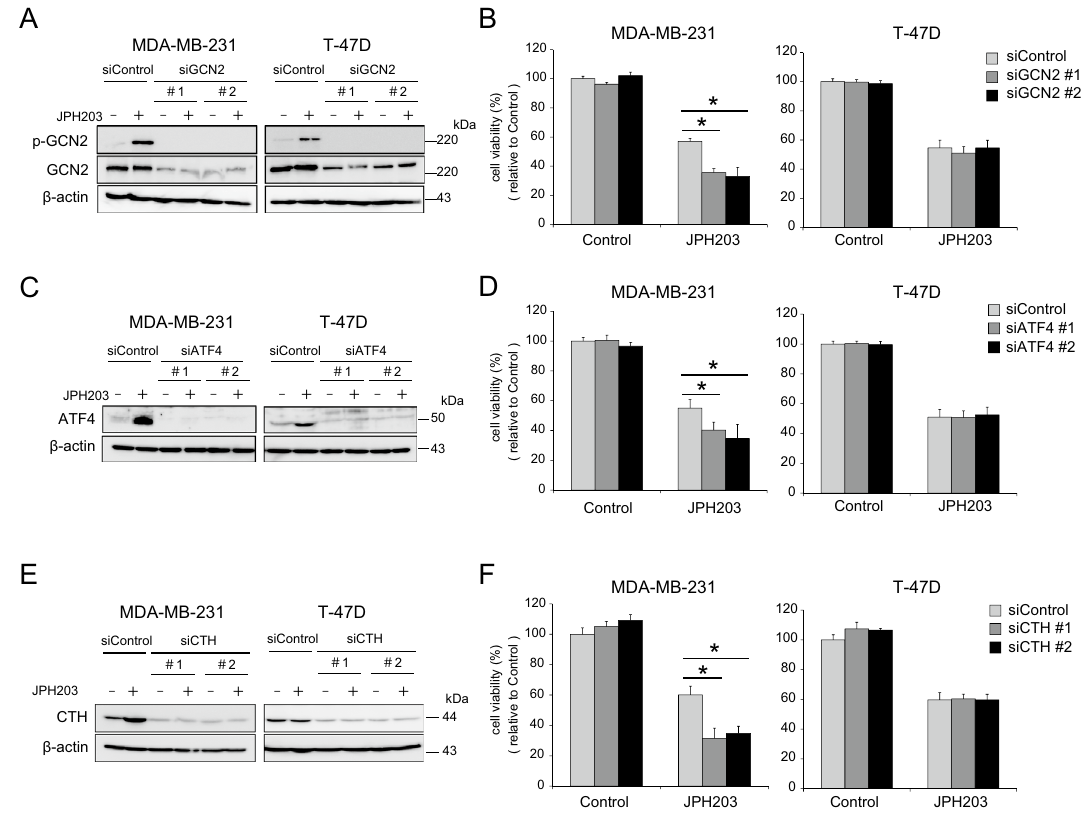
Figure 4. Effect of JPH203 in GCN2 , ATF4 , or CTH knockdown cells. ( A , C , E ) MDA-MB-231 and T-47D cells were transfected with control (scrambled) or GCN2 ( A ), ATF4 ( C ), CTH ( E ) siRNA. These transfected cells were incubated in the presence/absence of 100 μM (MDA-MB-231) or 5 μM (T-47D) of JPH203 for 12 h. The cell lysates were subjected to western blot and probed for each targeted molecule and βactin (loading control). ( B , D , F ) These knockdown cells were cultured in the absence or presence of 100 μM (MDA-MB-231) or 5 μM (T-47D) of JPH203 for 48 h and cell viability were assessed by MTT assay. *p <